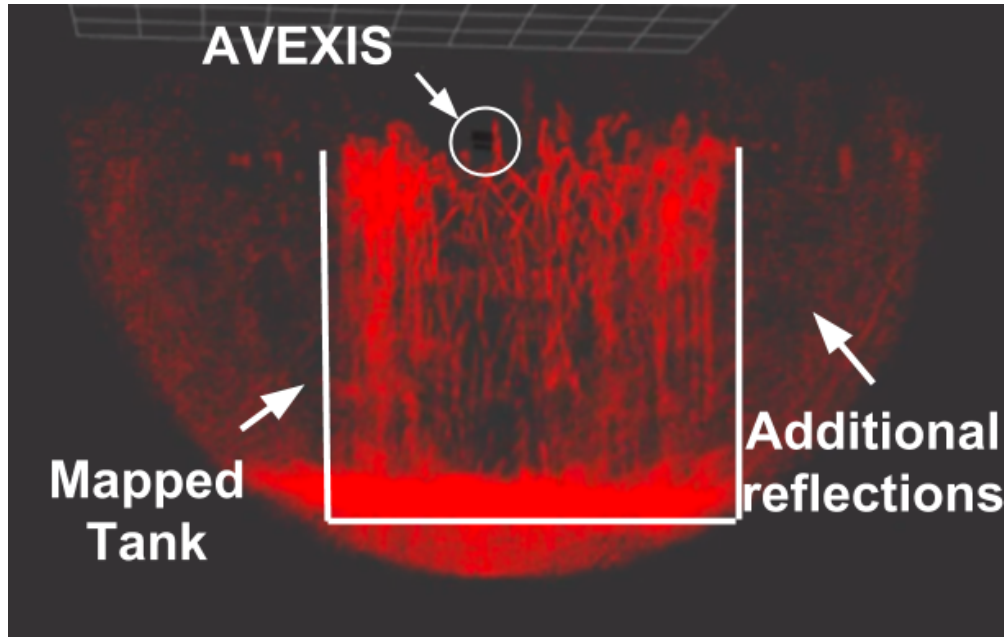
Figure 16. Output map showing the input from the sonar and positioning the robot on the output from the localization